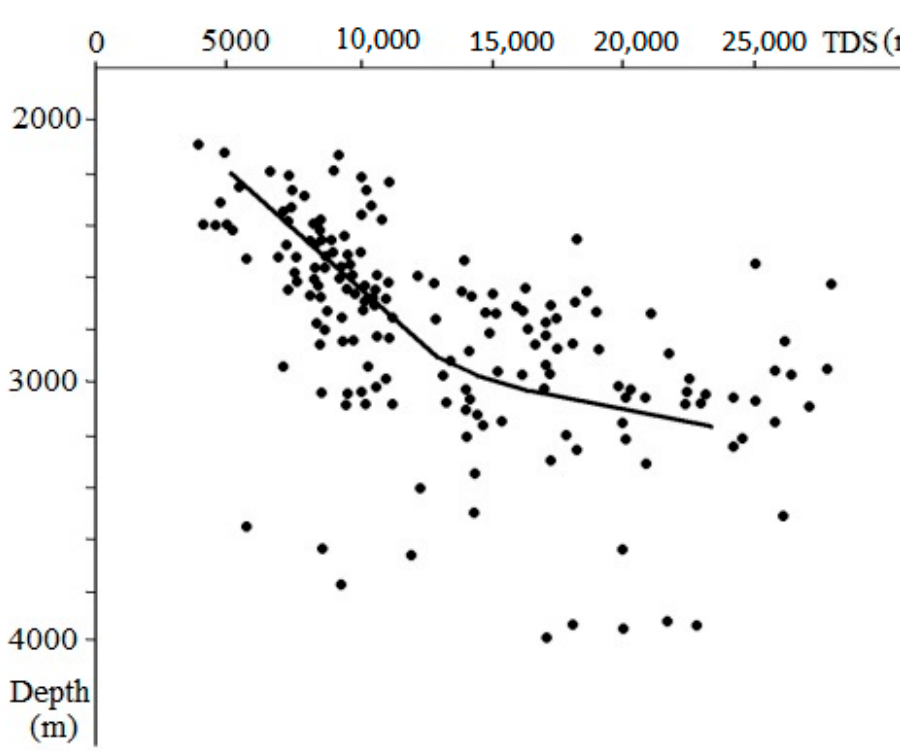
Figure 4. Relationship between the TDS and the burial depth of Paleogene fluid in the Huanghua depression.